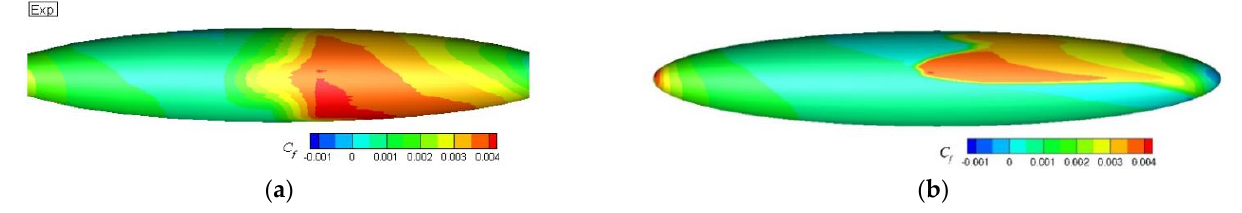
Figure 11. Experimental measurement (left) and computation using γ -Re θ t -CF SST-2003. ( a ) Exp. ( b ) R T,FS =0.1.